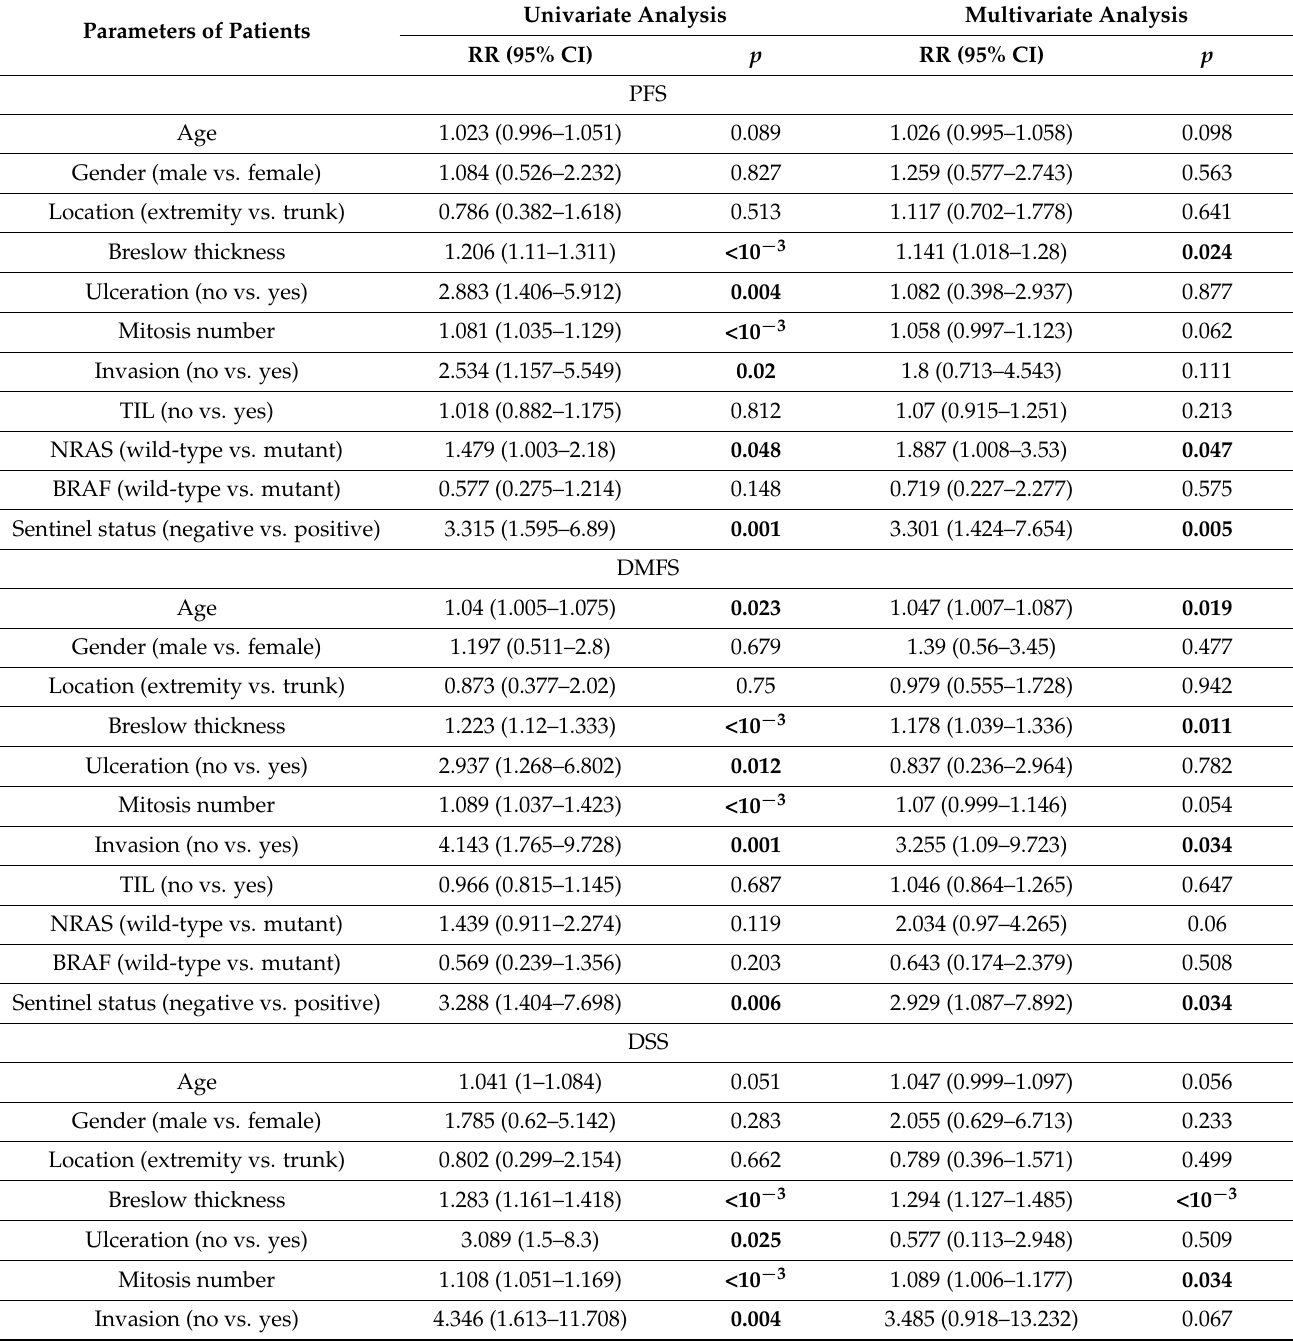
Table 5. Cox univariate and multivariate analysis of various prognostic factors in melanoma patients, according to different survival endpoints (PFS: progression-free survival; DMFS: distant metastasis-free survival; DSS: disease-specific survival, OS: overall